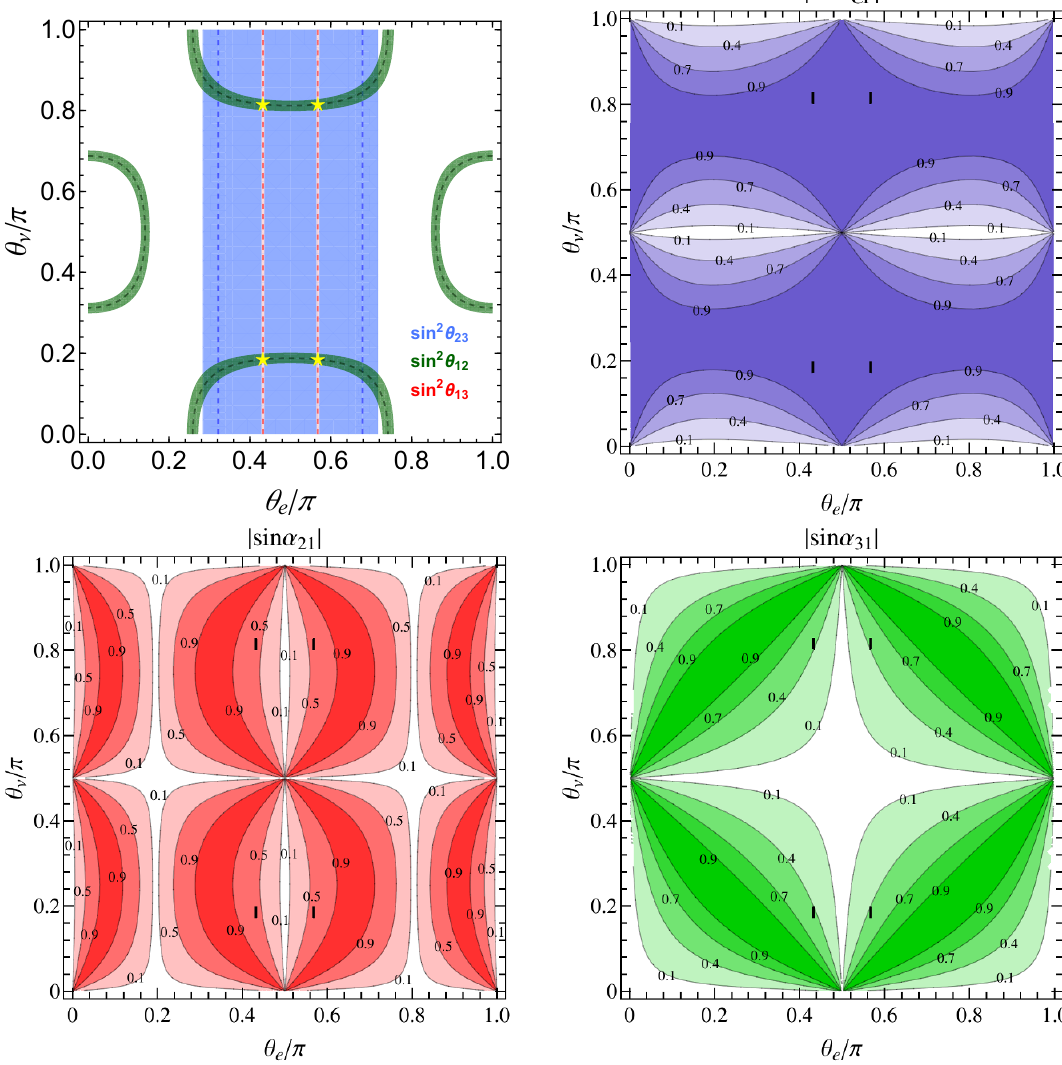
Figure 1 . The contour plots of sin 2 (cid:18) ij and the CP violation phases j sin (cid:14) CP j , j sin (cid:11) 21 j and j sin (cid:11) 31 j in the plane (cid:18) (cid:23) versus (cid:18) e for the mixing pattern U I; 6 with ’ 1 = (cid:25)= 4 and ’ 2 = (cid:25)= 2 which can be achieved from the D 4 (cid:13)avor group. The upper-left panel is the contour plots of sin 2 (cid:18) ij . The red, green and blue areas denote the 3 (cid:27) contour regions of sin 2 (cid:18) 13 , sin 2 (cid:18) 12 and sin 2 (cid:18) 23 respectively. The dashed contour lines stand for the corresponding experimental best (cid:12)t values. The 3 (cid:27) ranges and the best (cid:12)t values of the mixing angles are taken from [2]. The best (cid:12)tting values of (cid:18) e;(cid:23) are indicated with yellow pentagrams. The black areas represent the regions for which all the three lepton mixing angles are compatible with experimental data at 3 (cid:27)